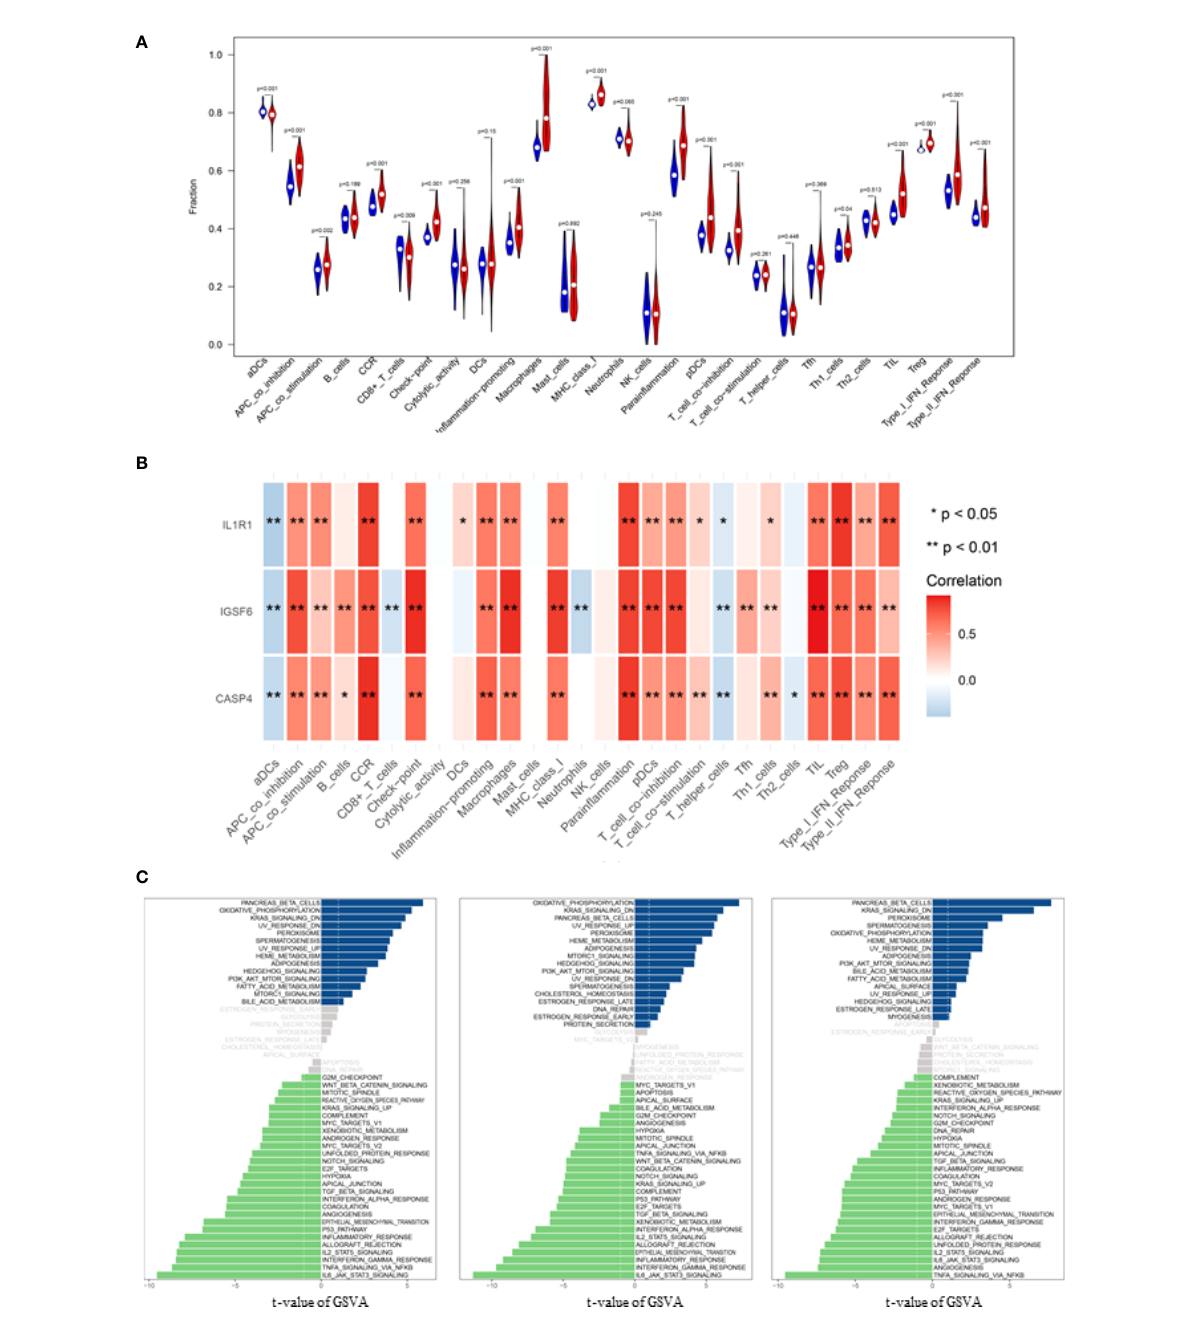
FIGURE 4 Correlation analysis of in fi ltrating immune cells and Gene set variation analysis (GSVA). (A) Differences in immune in fi ltration between SCI and normal control groups. Blue represents the normal control group, and red represents SCI group. p-value <0.05 was considered statistically signi fi cant. (B) * p = < 0.05, ** = p < 0.01, and non-* = statistically insigni fi cant. The color of the squares represents the closeness degree of the relationship between the genes and immune cells, the darker the color, the higher the p-value, and the lighter the color, the lower the p-value. (C) The GSVA results demonstrated the pathway differences of these key gene expressions in